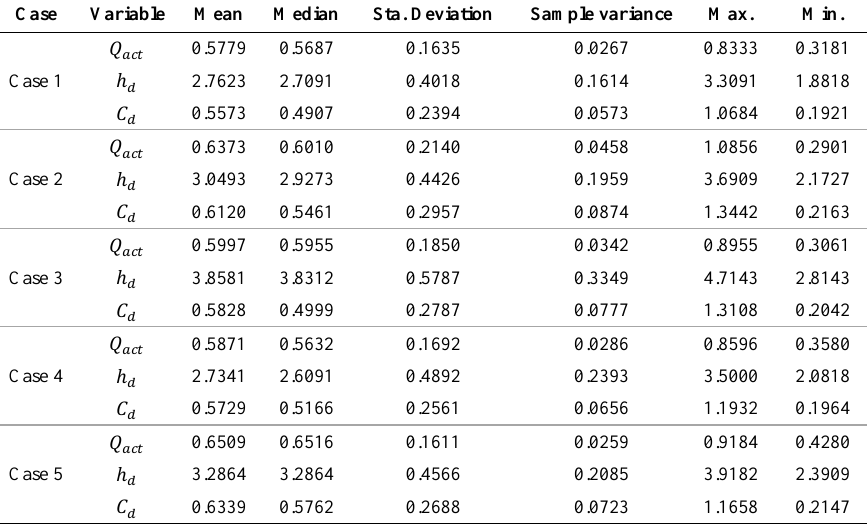
Figure 14. The relation between specific energy and flow velocity at downstream Table 2. Statistical data of the experimental